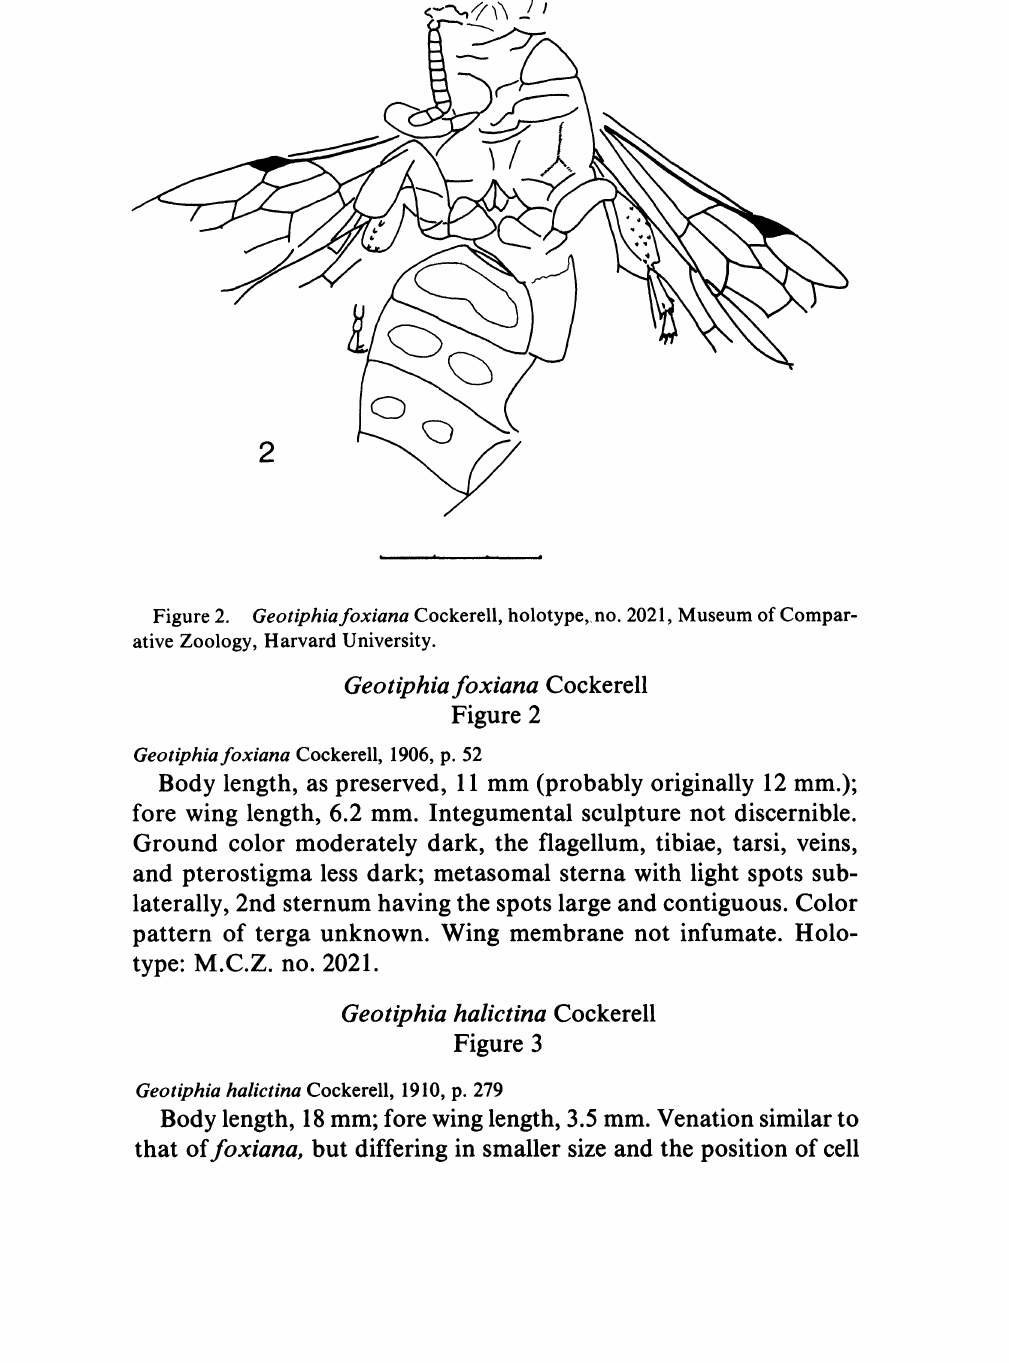
Geotiphia halictina Cockerell, 1910, p.